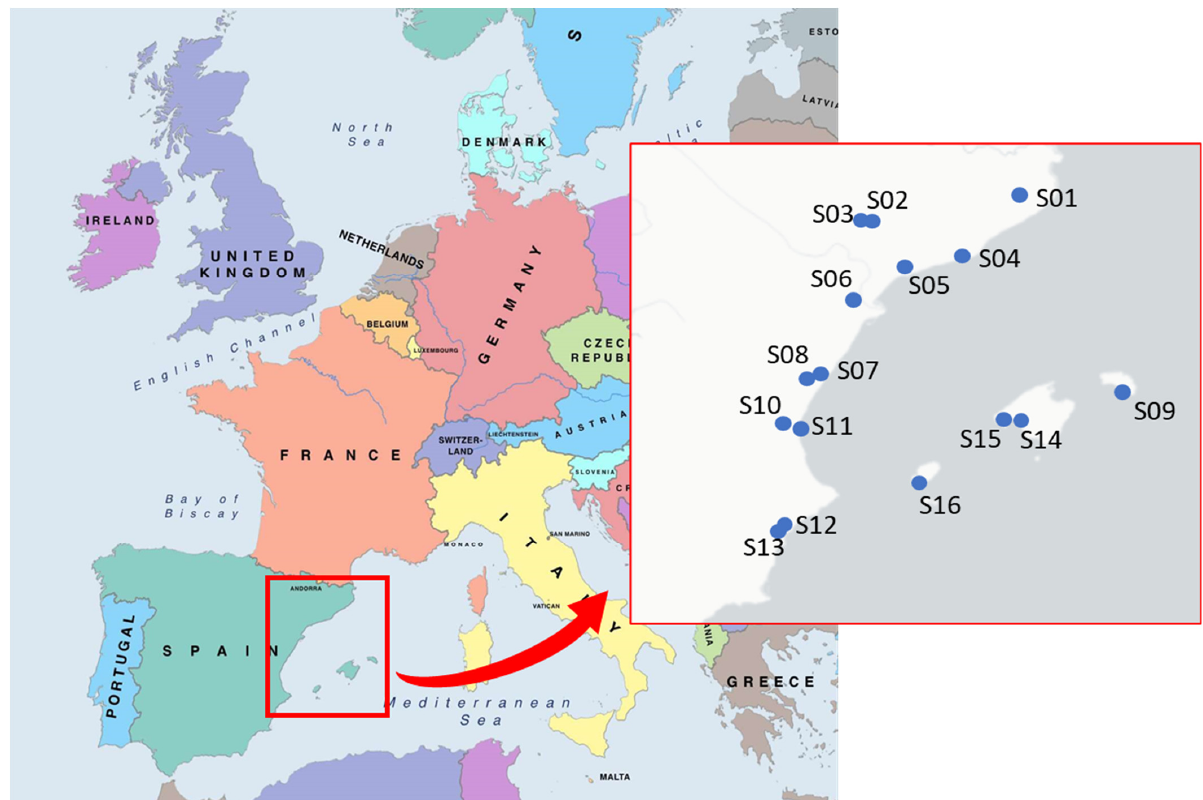
Figure 1. Geographical area studied and location of measuring stations. Map obtained from https://mapswire.com/ (accessed on 8 March 2023).